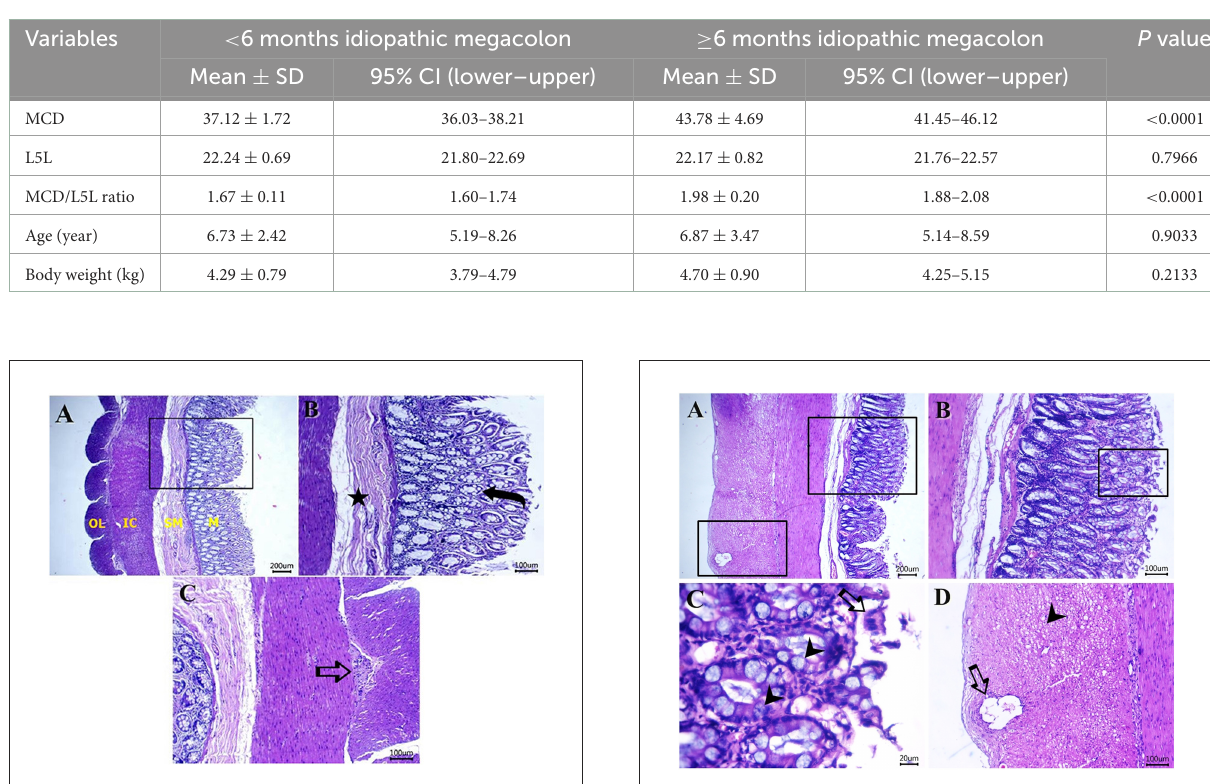
FIGURE6 Photomicrograph of H&E-stained sections from cat idiopathic megacolon that had < 6 months duration of constipation/obstipation showing mild-moderate degenerative changes: (A–C) desquamated epithelium (arrow) and metaplastic changes of the colonic columnar epithelium into goblet cells (arrowheads). (D) Vacuolated (arrowhead) and necrotic enteric myocytes (arrow). Scale bar 200, 100, 20, and 100 µ m,